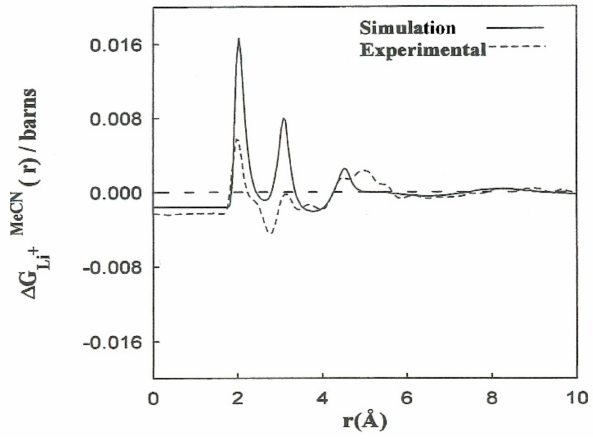
Figure 3. Comparison between the ∆ G MeCN and (- - - -) the experiments from Ref.